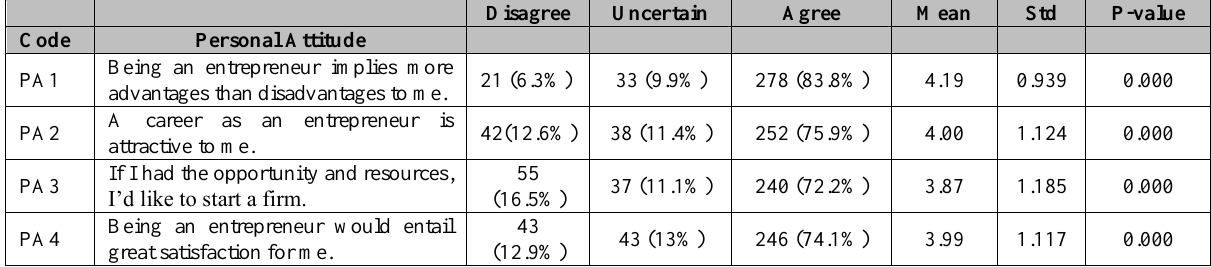
Table 3. Frequency Distribution of Perceived Attitude Towards Entrepreneurship Disagree Uncertain Agree